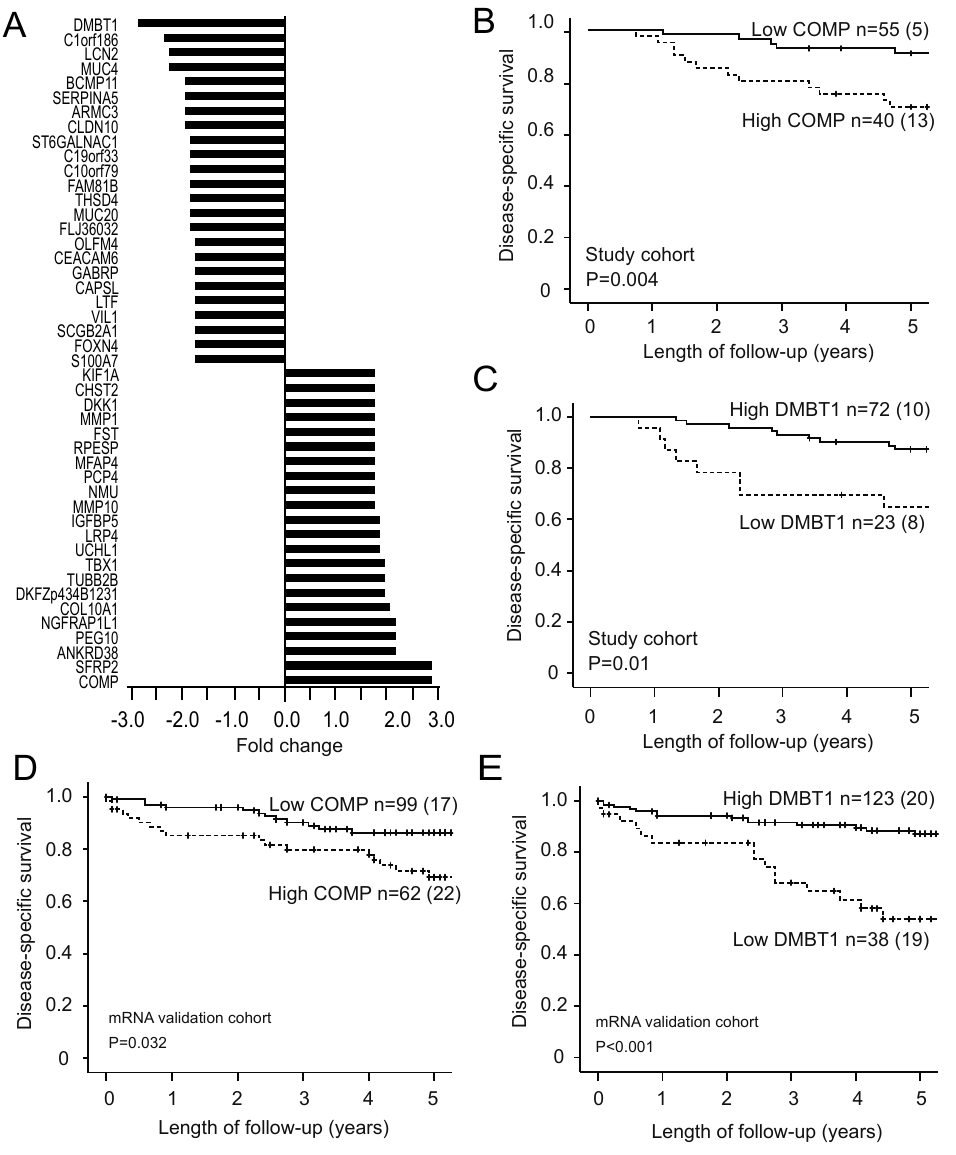
Figure 3. The differentially expressed genes in patients with high RPI (compared with patients with low RPI) were 22 up-regulated and 24 downregulated genes when employing a fold change cut-off of 1.7 ( p < 0.001 for all; ( A )). High expression of the most upregulated gene ( COMP ) and low expression of the most downregulated gene ( DMBT1 ) are associated with poor disease-specific survival in both the study cohort ( p = 0.004 and p = 0.010 in ( B , C ), respectively; n = 95) and the microarray validation cohort ( p = 0.032 and p < 0.001 in ( D , E ), respectively; n = 161). For each category, number of cases/number of cases dying from EC. p- values refer to the log-rank test. RPI: radiomic prognostic index; COMP: cartilage oligomeric matrix protein; DMBT1: deleted in malignant brain tumors 1.